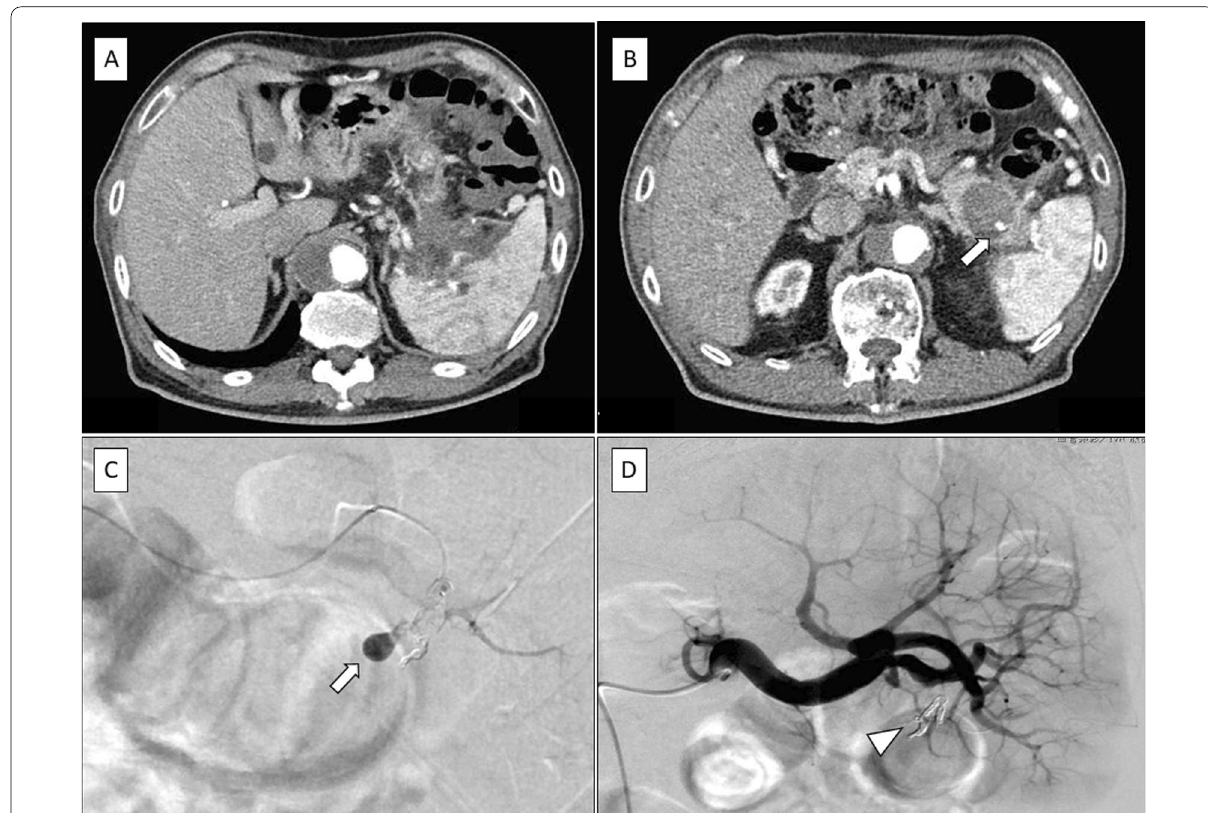
Fig. 2 A Contrast-enhanced computed tomography showing fluid collection around the pancreatic tail. B With pseudoaneurysm of the splenic artery (arrow). C Abdominal angiography showing pseudoaneurysm of the splenic artery (arrow). D Transcatheter arterial embolization was performed